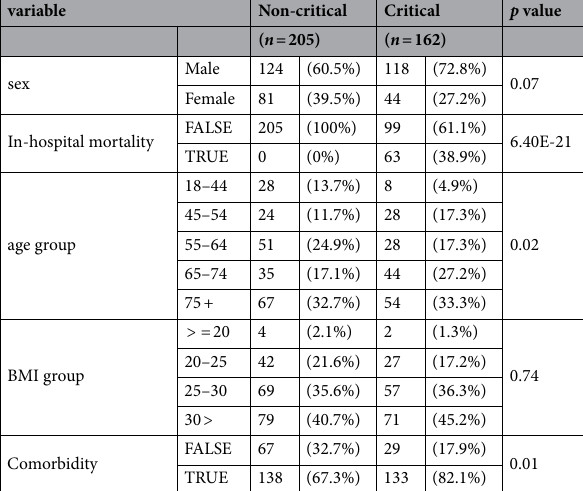
Table 1. Population sample characteristics. BMI: body mass index.